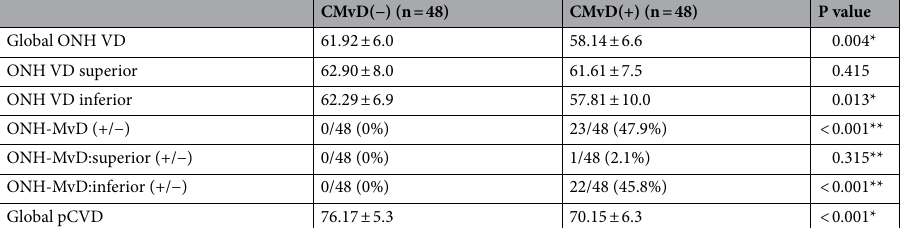
Table 2. Optic nerve head and parapapillary choroidal vessel density measurements in eyes with open- angle glaucoma with (+) or without (−) choroidal microvasculature dropout (CMvD). Data are reported as a mean ± standard deviation. ONH optic nerve head, VD vessel density, ONH VD optic nerve head vessel density, pCVD parapapillary choroidal vessel density, ONH-MvD optic nerve head microvasculature dropout. * P < 0.05 by unpaired t-test unless otherwise indicated. **Chi-square